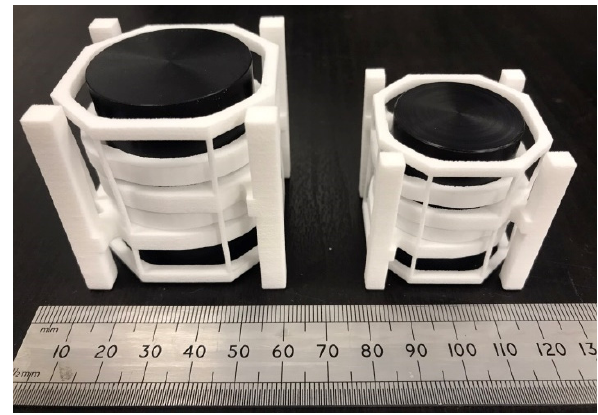
Figure 12. Examples of the design specimens in several sizes.